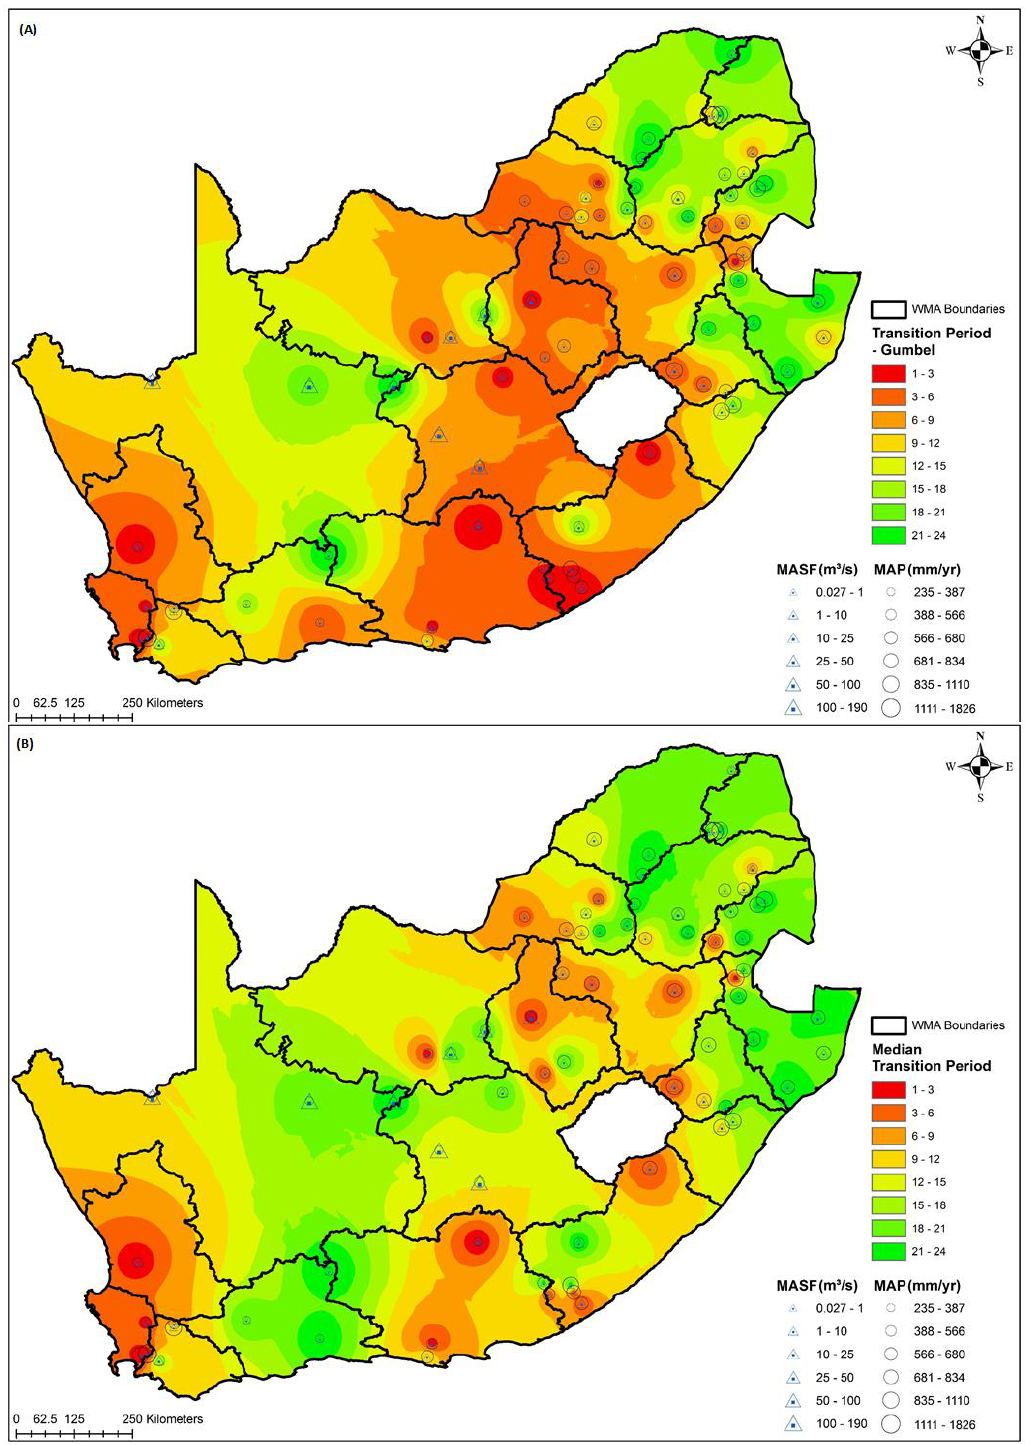
Figure 10. The drought transition period from meteorological to hydrological calculated using the two-parameter statistical distribution functions ( A ) Gumbel and ( B ) the average of the five selected statistical distribution functions.